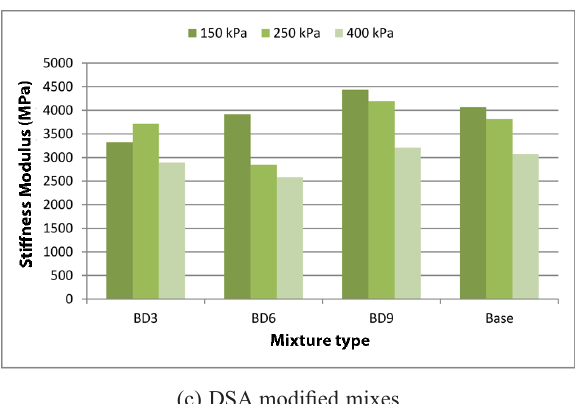
Fig. 10. Stiffness modulus of various modified